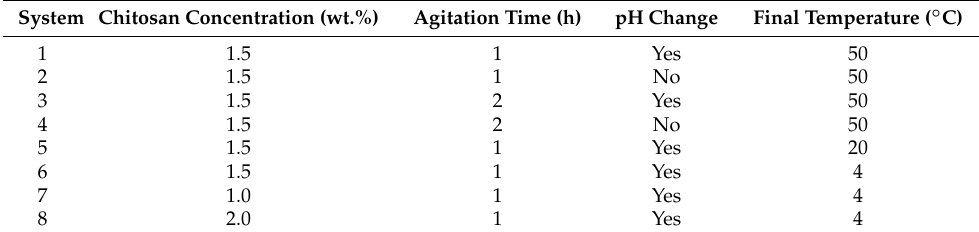
Table 1. Studied systems obtained for different processing conditions. System Chitosan Concentration (wt.%) Agitation Time (h) pH Change Final Temperature ( ◦